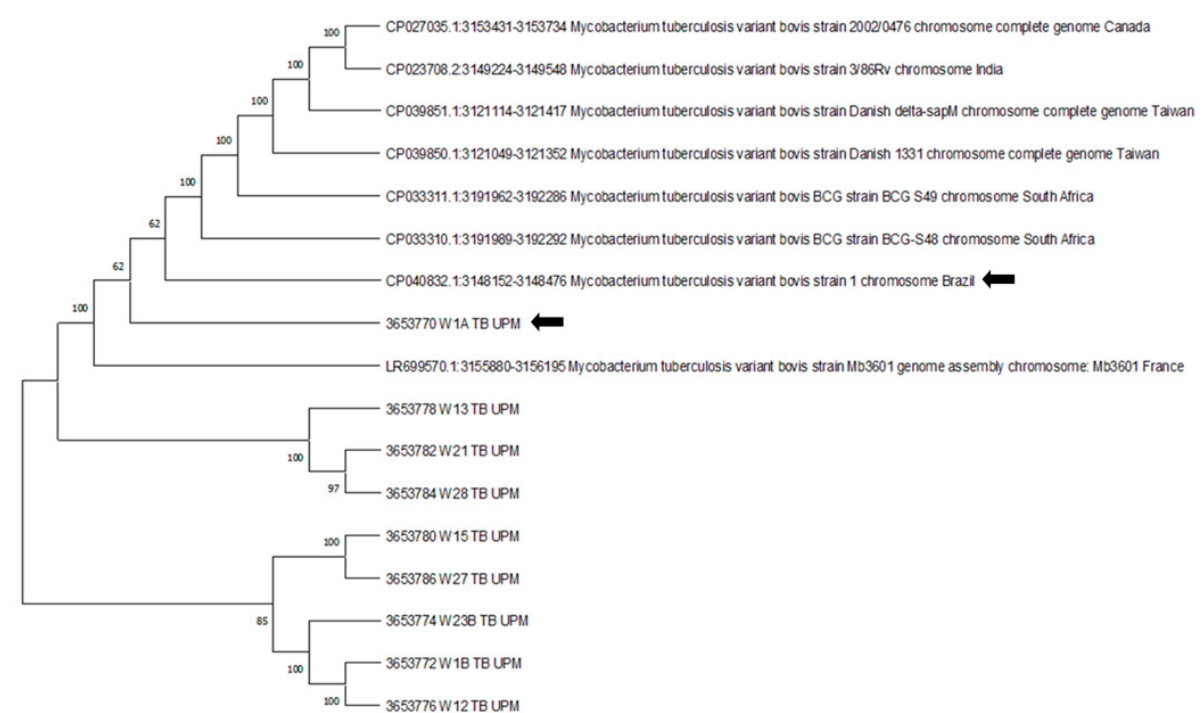
Figure 3. The phylogenetic tree was inferred using the UPGMA method. The optimal tree with the sum of branch length = 1.46536283 is shown. The percentage of replicate trees in which the associated taxa clustered together in the bootstrap test (1000 replicates) are shown next to the branches. The evolutionary distances were computed using the P-distance method and are in the units of the number of base differences per site. The arrow showed a close relationship between the Malaysian strain 3653770 W1A TB UPM with CP040832.1: M. tb variant bovis strain1 chromosome from Brazil .